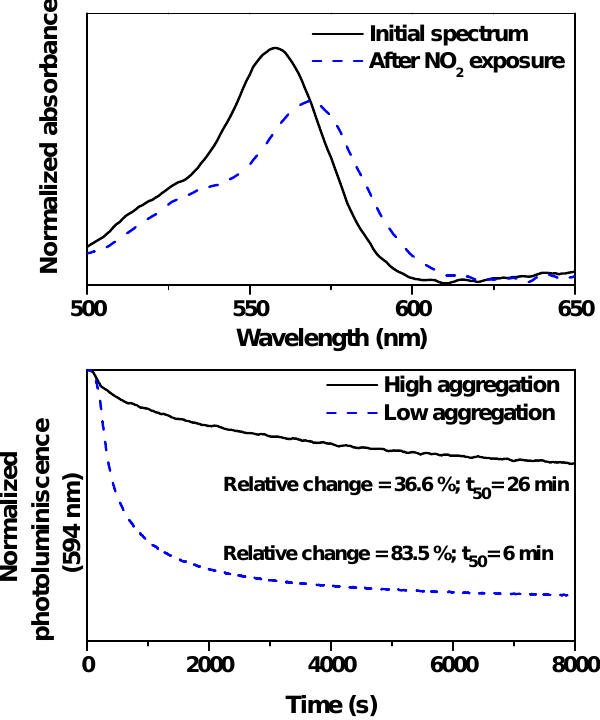
Figure 7. Top panel: spectral changes of the visible absorption spectrum of RosB (3.6 µ M) bounded to SiO 2 before and after NO 2 (50 ppm) exposure. Bottom panel: photoluminescence response to NO 2 (50 ppm) of RosB infiltrated in SiO 2 . The continuous line corresponds to 36 µ M concentration (highly aggregated solution) and the dashed-lines stand for the 3.6 µ M solution